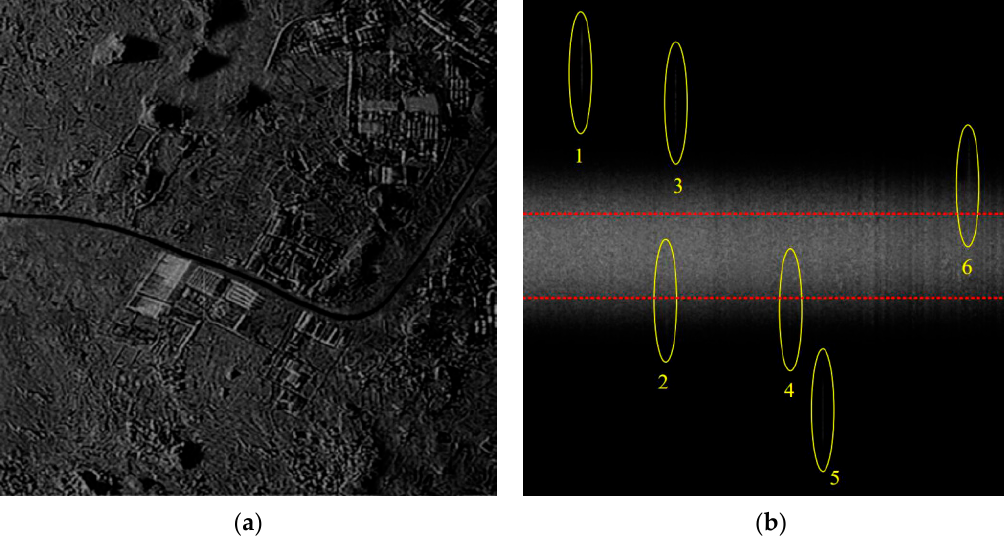
Figure 5. ( a ) The SAR image without 3dB clutter suppression. ( b ) Targets and clutter spectrum in the RD domain.